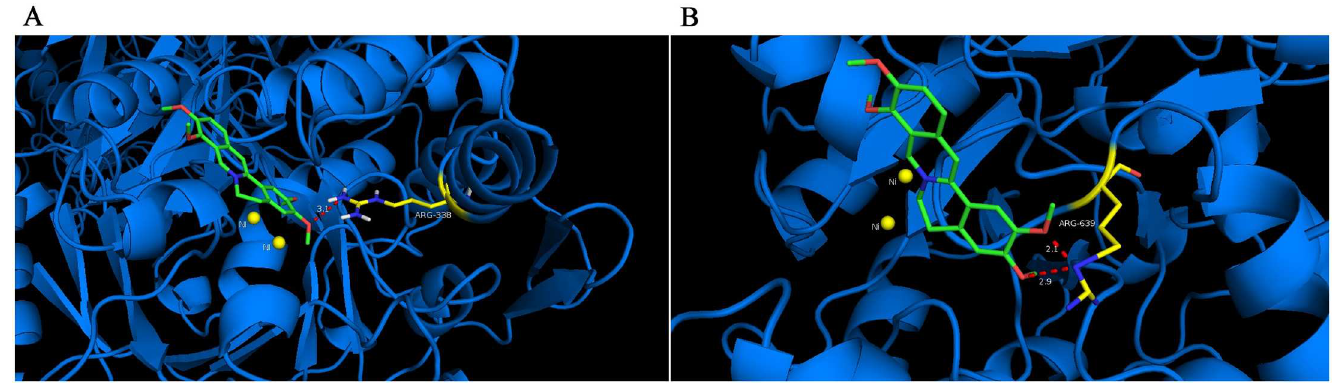
Fig 7. Docked conformation of of Pal in the catalytic site of HPU (A) and JBU (B). Hydrogenbondinginteractions are shown by dashes. These figures were created by PyMol. (coloredby atom: carbon is green, nitrogenis blue, oxygen is red, hydrogenis gray and sulfur is yellow)